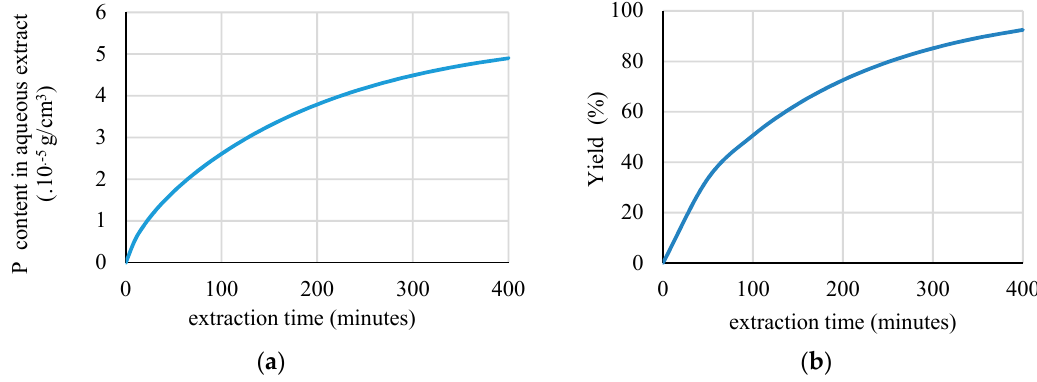
Figure 4. The profile of: ( a ) P concentration in aqueous extract; and, ( b ) the yield of extraction as a function of extraction time.